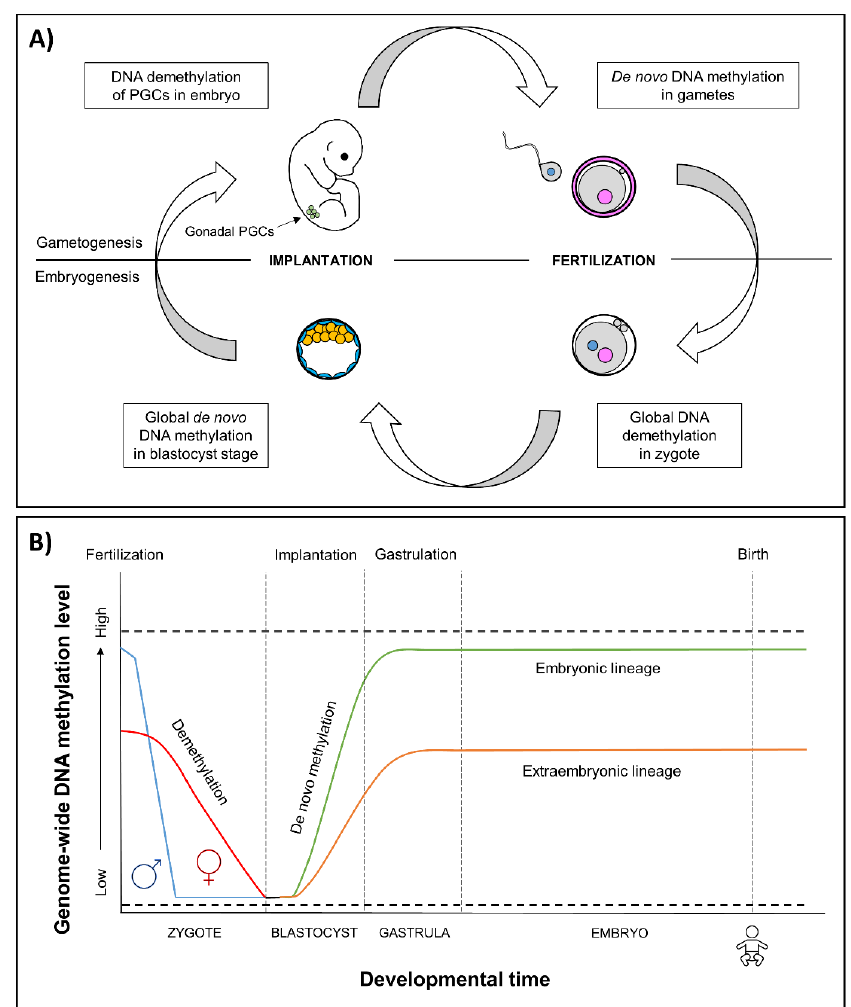
Figure 1. ( A ) Epigenetic reprogramming in the germ line and in somatic cells. Reprogramming occurs in two phases of in utero development, one after fertilization in the preimplantation embryo and the other in the developing gametes of the fetus. In gametogenesis, primordial germ cells (PGCs) become globally demethylated early in development [40]. De novo methylation begins in prospermatogonia in male germ cells during spermatogenesis and after birth in maturing oocytes. In embryogenesis, the epigenetic reprogramming begins after fertilization and continues until the blastocyst stage. Genome-wide de novo methylation occurs during implantation and gastrulation, leading to the formation of different cell types. ( B ) Epigenetic reprogramming in embryos. After fertilization, in the beginning of reprogramming, methyl marks are actively erased in paternal genome (blue line), and passively erased in maternal genome (red line) [41]. By the blastocyst stage, the genome is almost completely hypomethylated [42]. Blastocyst cells divide and differentiate into the following two distinct lineages: the pluripotent inner cell mass, which will become the developing fetus, and trophoectoderm, which forms the extraembryonic tissues. Demethylation is followed by genome- wide de novo methylation during implantation and gastrulation [39], in which the reestablishment of epigenetic marks is more limited in the extraembryonic lineage (orange line) compared to embryonic lineage (green line) [43]. An exception to methylation is made by imprinted genes that remain either methylated or unmethylated throughout epigenetic reprogramming (dashed lines)